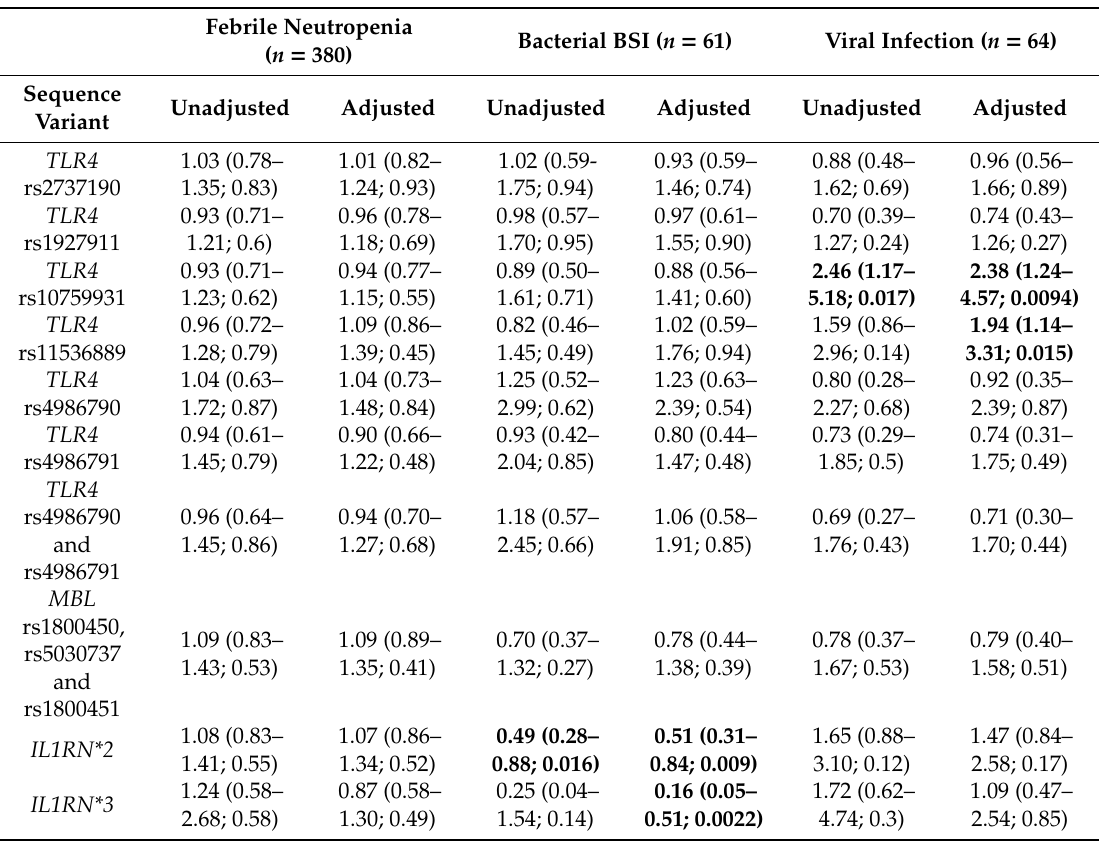
Table 2. Association between sequence variants in genes coding for TLR4 , MBL , and IL-1Ra and the risk of FN and specific MDI during pediatric ALL